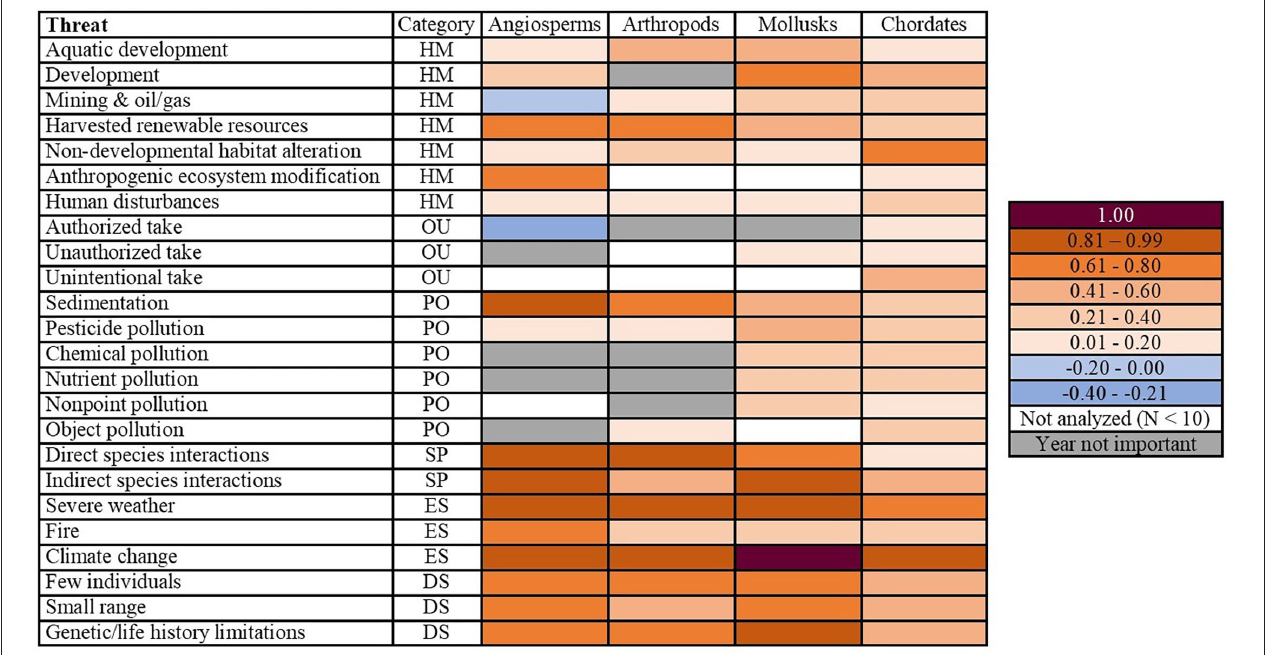
2000 ( Appendices 4 , 5 ). Year of listing was not a predictor of